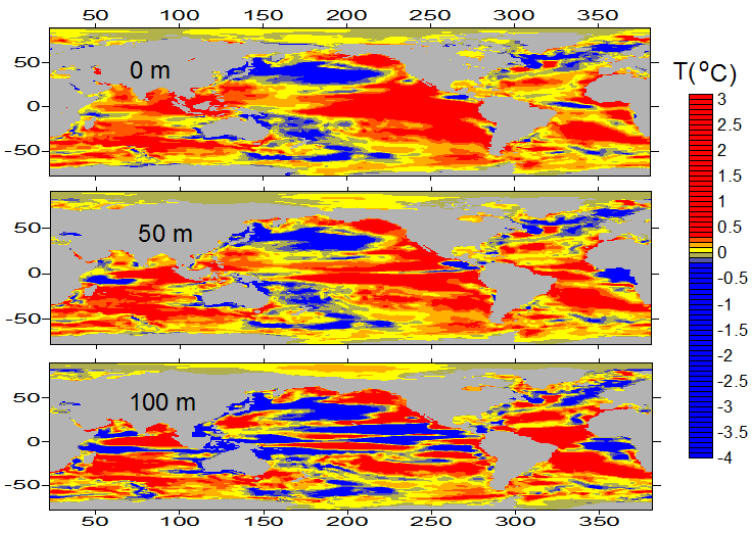
Figure 5. Perturbations in the WO temperature (°C) in the upper mixed layer (levels 0, 50, 100 m) from the phase of 1948–1974 to the phase of